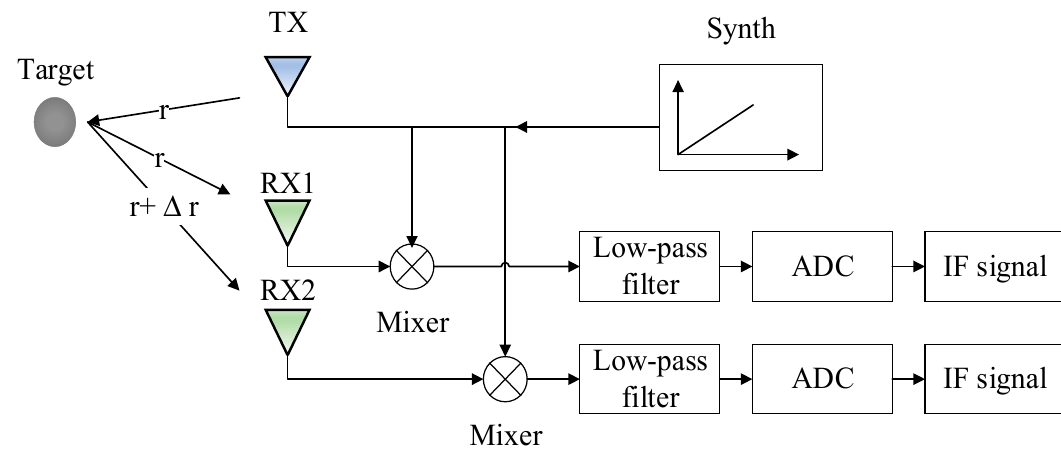
Figure 2. Simplified structure of radar sensor.